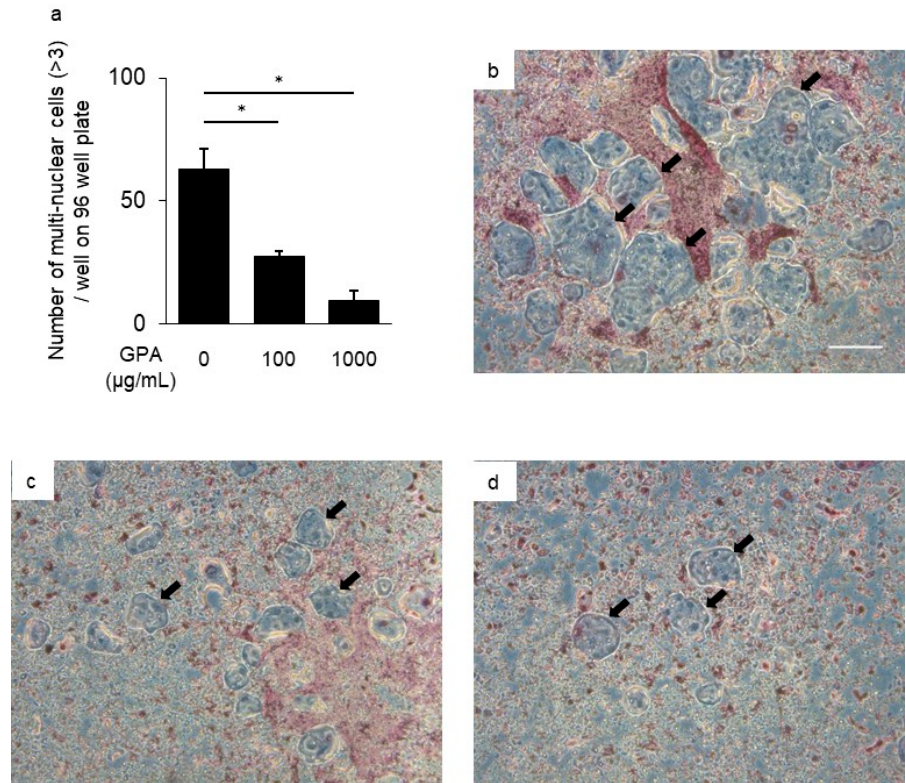
Figure 3. Inhibitory effect of geniposidic acid (GPA) on osteoclast differentiation of mouse BMMCs. BMMCs (2 × 10 5 cells/well) were cultured on 96-well plates in the presence of sRANKL (100 ng/mL) and M-CSF (20 ng/mL) in the presence or absence of GPA (( b ): 0 µg/mL, ( c ): 100 µg/mL, ( d ): 1000 µg/mL) for seven days. ( a ) Osteoclasts with multiple nuclei (>3) in 96-well plates were counted (black arrowheads). The data represent the results of three independent experiments. ( b – d ) Representative TRAP-stained images of multinuclear osteoclasts in 96-well plates on day 7. Original magnification ×100; Scale bar = 100 µm. Results are shown as the mean ± SD. * Significantly larger number of osteoclasts by Student’s t -test (* p < 0.01).